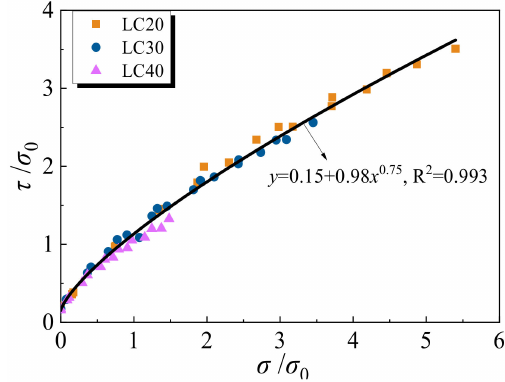
Figure 13. Normalized τ - σ